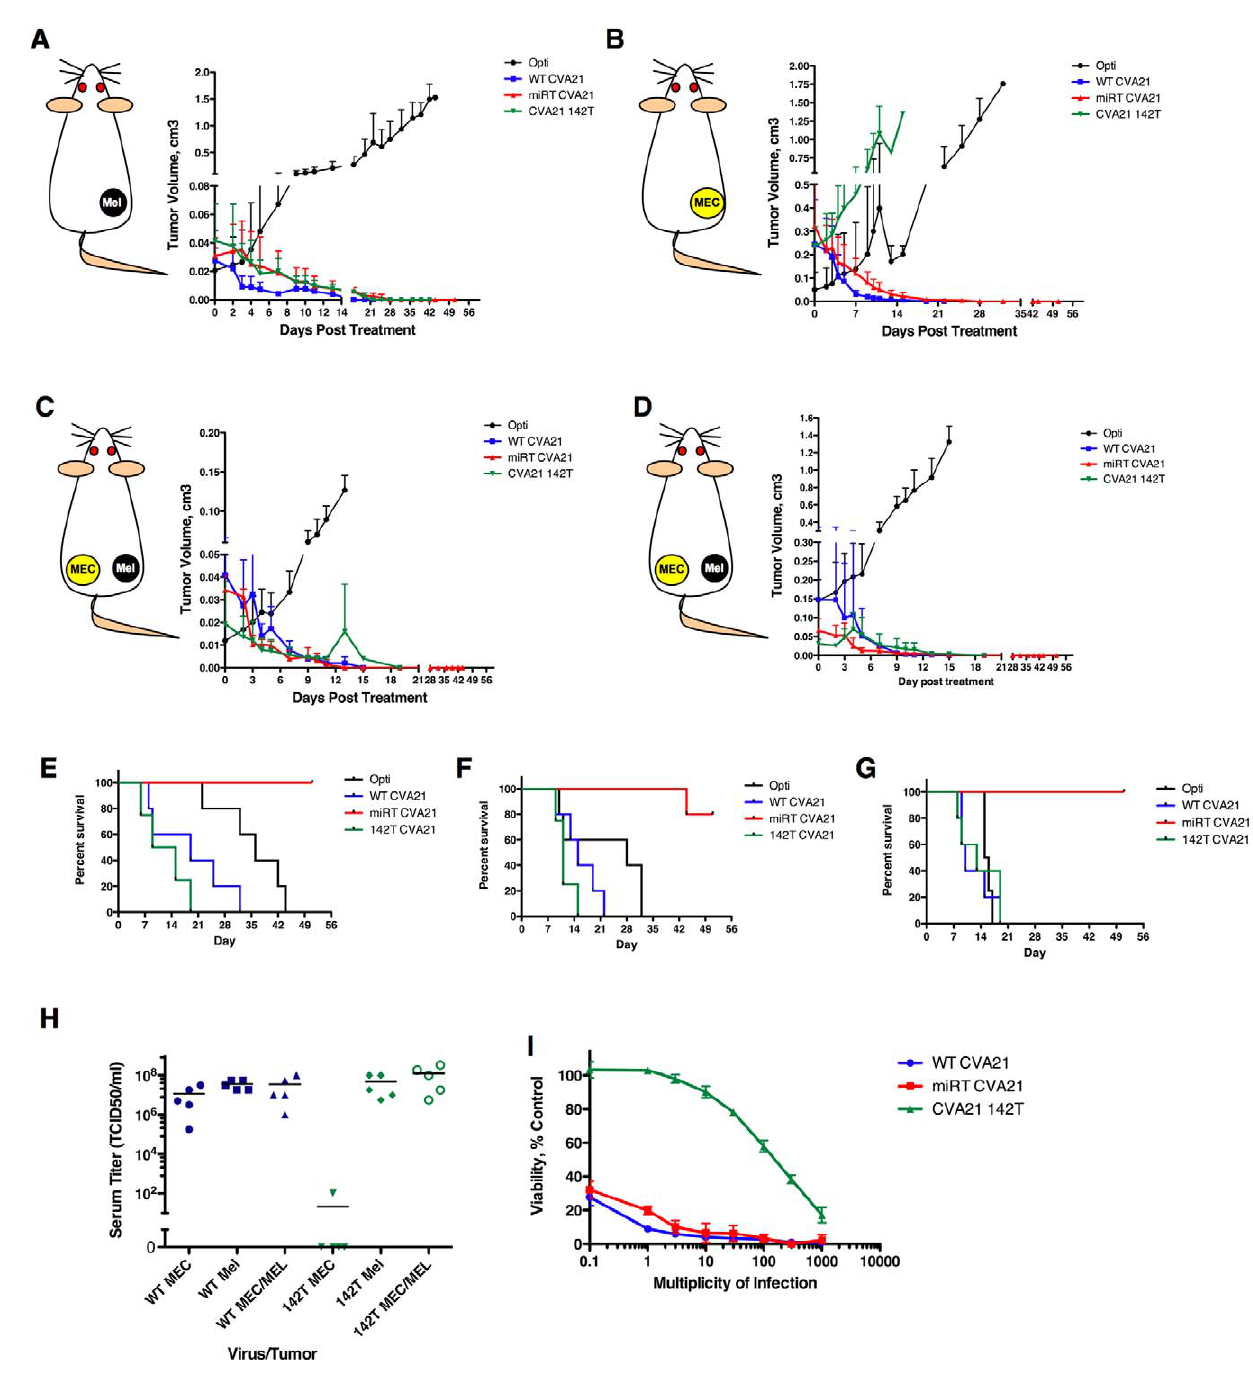
Figure 6. MicroRNAs regulate virus tropism in vivo, but can be saturated by high-level viremia. (A) SCID mice bearing Mel-624 xenografts were treated with one intratumoral dose of 1 6 10 6 recombinant CVA21 and tumors measured daily. (B) SCID mice bearing MEC-1 xenografts were treated with one intratumoral dose of 1 6 10 6 recombinant CVA21 and tumors measured daily. (C) SCID mice bearing bilateral Mel- 624 and MEC-1 xenografts were treated with one intravenous dose of 1 6 10 6 recombinant CVA21 and Mel-624 tumors measured daily. (D) SCID mice bearing bilateral Mel-624 and MEC-1 xenografts were treated with one intravenous dose of 1 6 10 6 recombinant CVA21 and MEC-1 tumors measured daily. (E) Kaplan-Meier survival graphs of mice in (A). (F) Kaplan-Meier survival graphs of mice in (B). (G) Kaplan-Meier survival graphs of mice in (C,D). (H) Virus titer in mouse serum in mice from (A–D). (I) In vitro saturation of miR-142 as determined by MTT assay in MEC-1 cells infected with rCVA21 at MOI .1-1000.